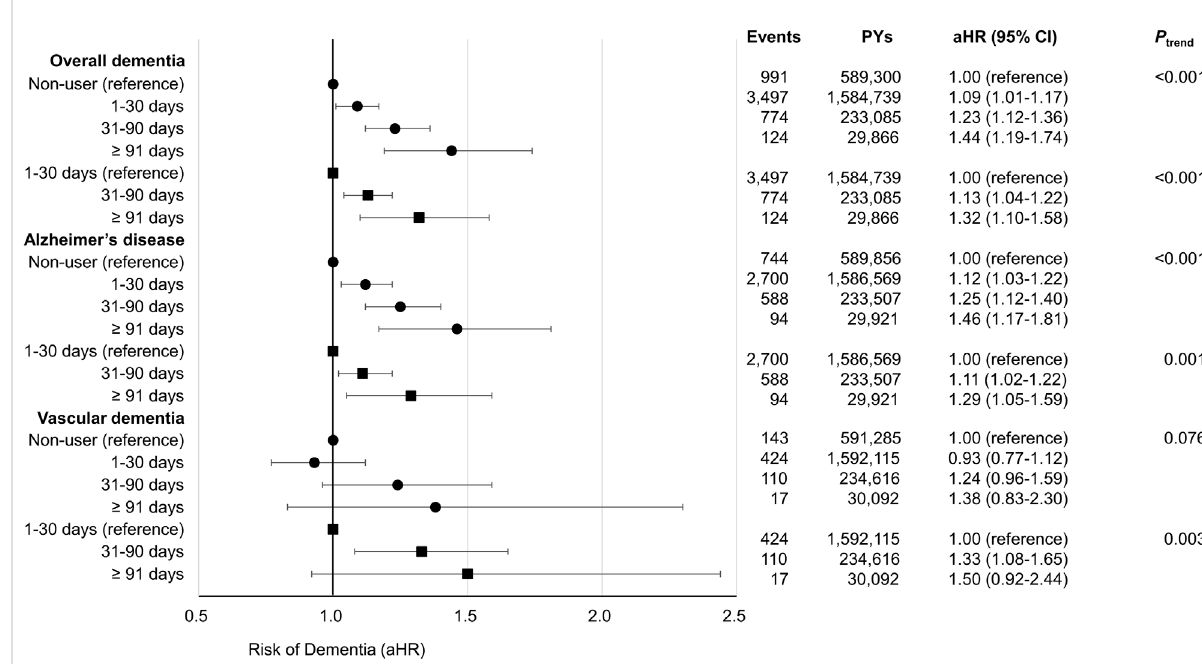
FIGURE 2 Forest plot indicates the association of cumulative days of antibiotic prescription with the risk of dementia. Acronyms; PYs, person-years; aHR, adjusted hazard ratio;CI, con fi denceinterval.The aHRswere calculated byCox proportional hazardsregression after adjustments forage, sex,body mass index, smoking status, alcohol consumption, physical activity, household income, Charlson comorbidity index, fasting blood sugar, systolic blood pressure, total cholesterol, and antidepressant use. In these analyses, antibiotic non-users were considered as the reference group.